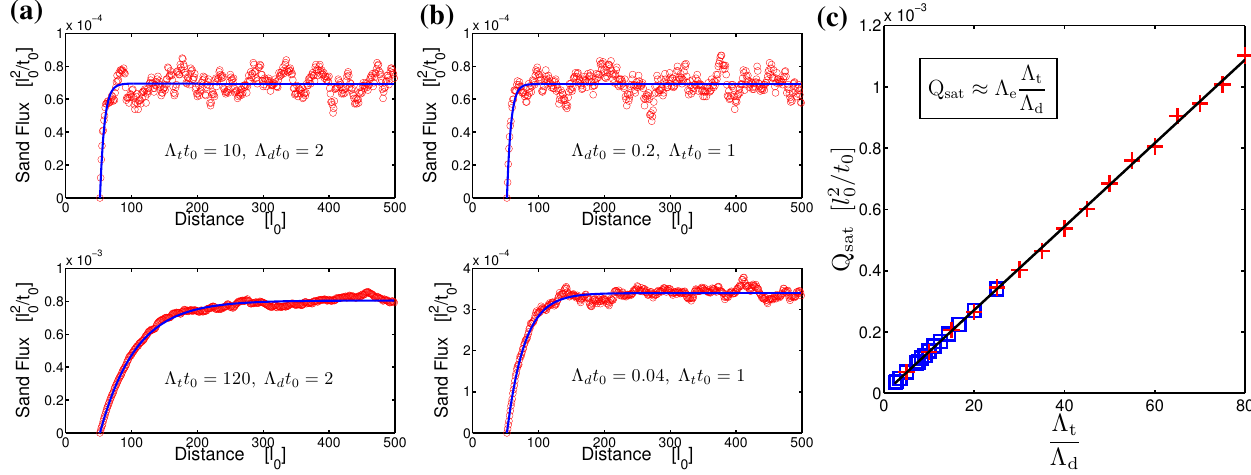
Fig. 6. Relation between Q sat and the rate parameters of the cellular automaton model. (a) Increase of Q sat with respect to an increasing 3 t value for 3 d /t 0 = 2. (b) Increase of Q sat with respect to a decreasing 3 d -value for 3 t /t 0 = 1. (c) Q sat with respect to 3 t /3 d , the mean distance traveled by a sedimentary cell: 3 d t 0 = 2 (blue squares), 3 t t 0 = 0 . 4 (red crosses). The slope of the linear relation is proportional to 3 e